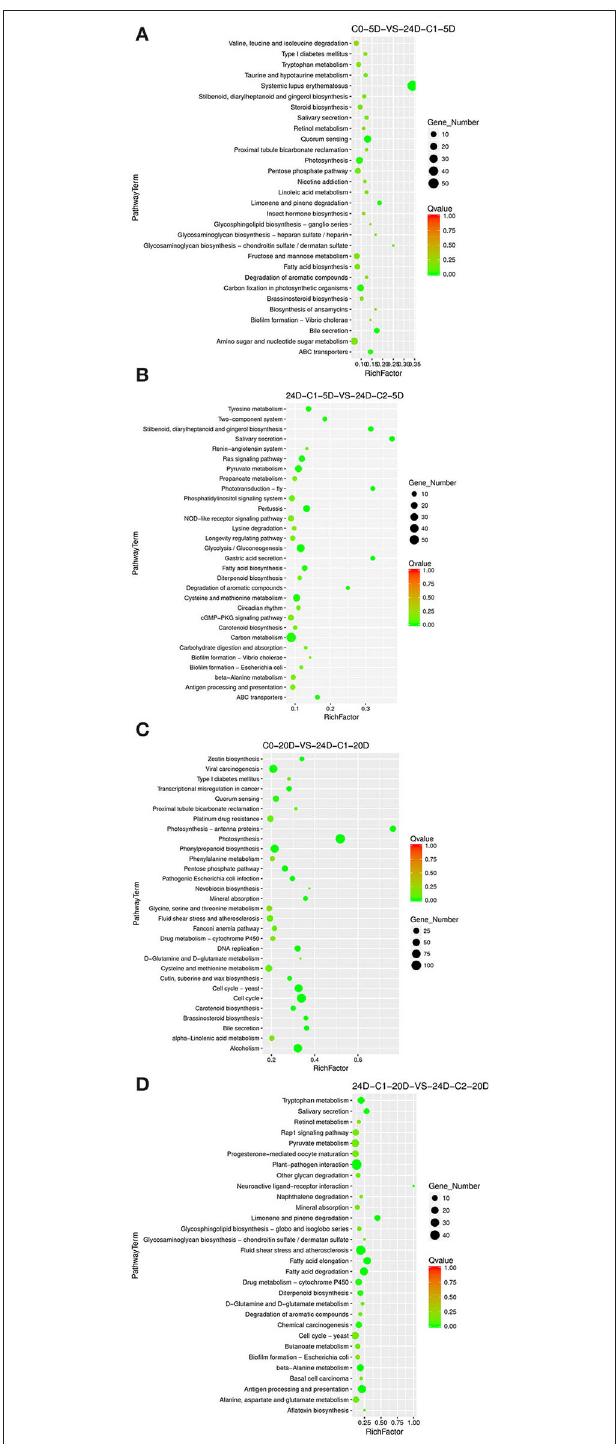
FIGURE 7 | The KEGG enrichment of DEGs in comparison groups under 2,4-D dose effect. (A) Pathways enriched in C0-5D vs. 24D-C1-5D; (B) Pathways enriched in 24D-C1-5D vs. 24D-C2-5D; (C) Pathways enriched in C0-20D vs. 24D-C1-20D; (D) Pathways enriched in 24D-C1-20D vs. 24D-C2-20D. 24D, 2,4-dichlorophenoxyacetic acid; C0, 0mg L − 1 ; C1, 0.025mg L − 1 ; C2, 0.05mg L − 1 ; 5D, 5 days’ treatment; 20D, 20 days’